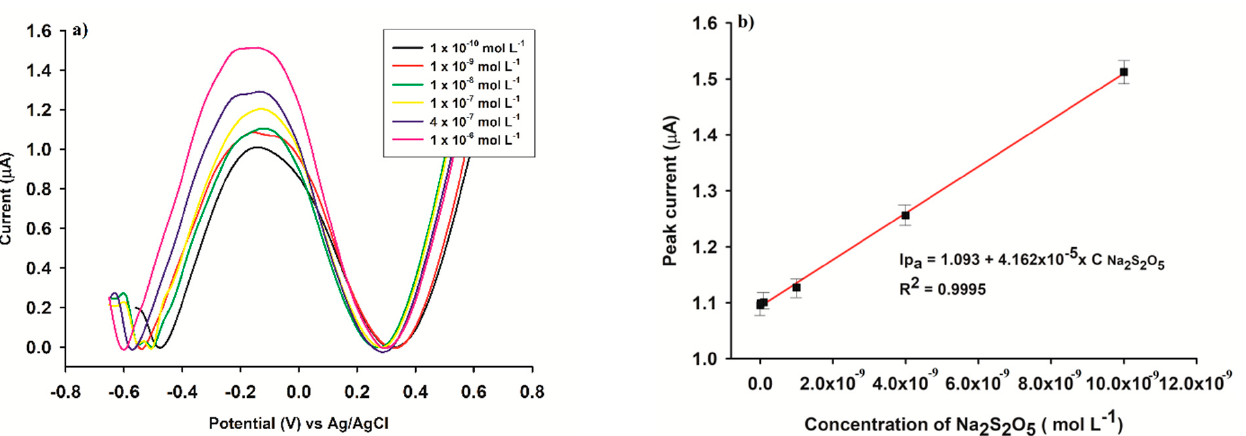
Figure 7. ( a ) Square wave voltammograms recorded with the Fe(TPFPP)Cl/rGO@Pd0 sensor in pH 4.5 containing different concentrations of Na 2 S 2 O 5 from 1.0× 10 − 10 mol L − 1 to 1.0× 10 − 6 mol L − 1 . ( b ) Calibration curve obtained with the Fe(TPFPP)Cl/rGO@Pd0 sensor from 1.0× 10 − 10 mol L − 1 to 1.0× 10 − 6 mol L − 1 . Working conditions: step potential, 0.03 V; amplitude, 0.1 V; and frequency, 10 Hz.